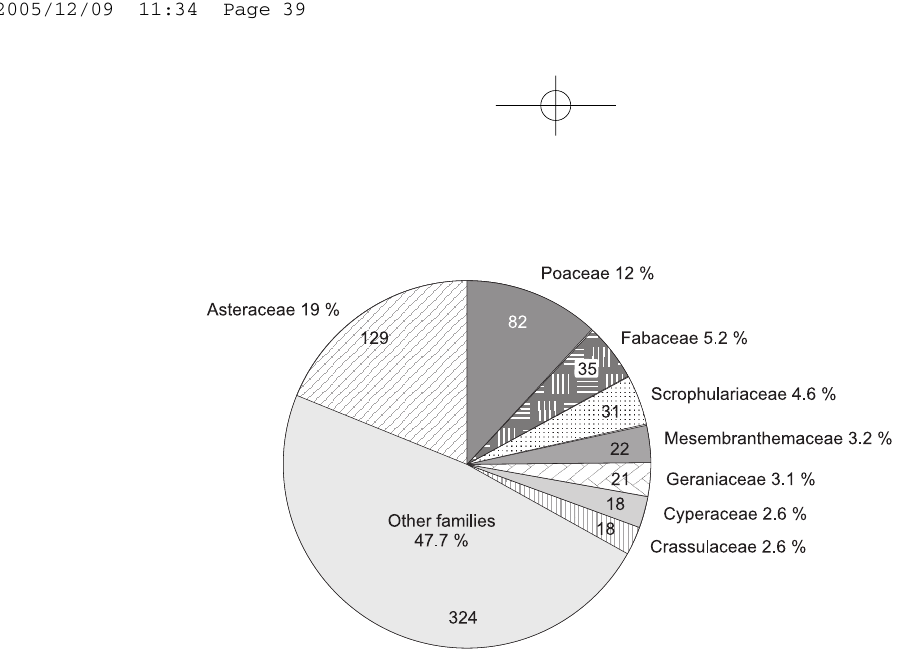
Fig. 3. Dominant plant families reflecting the number of species and percentage of the total